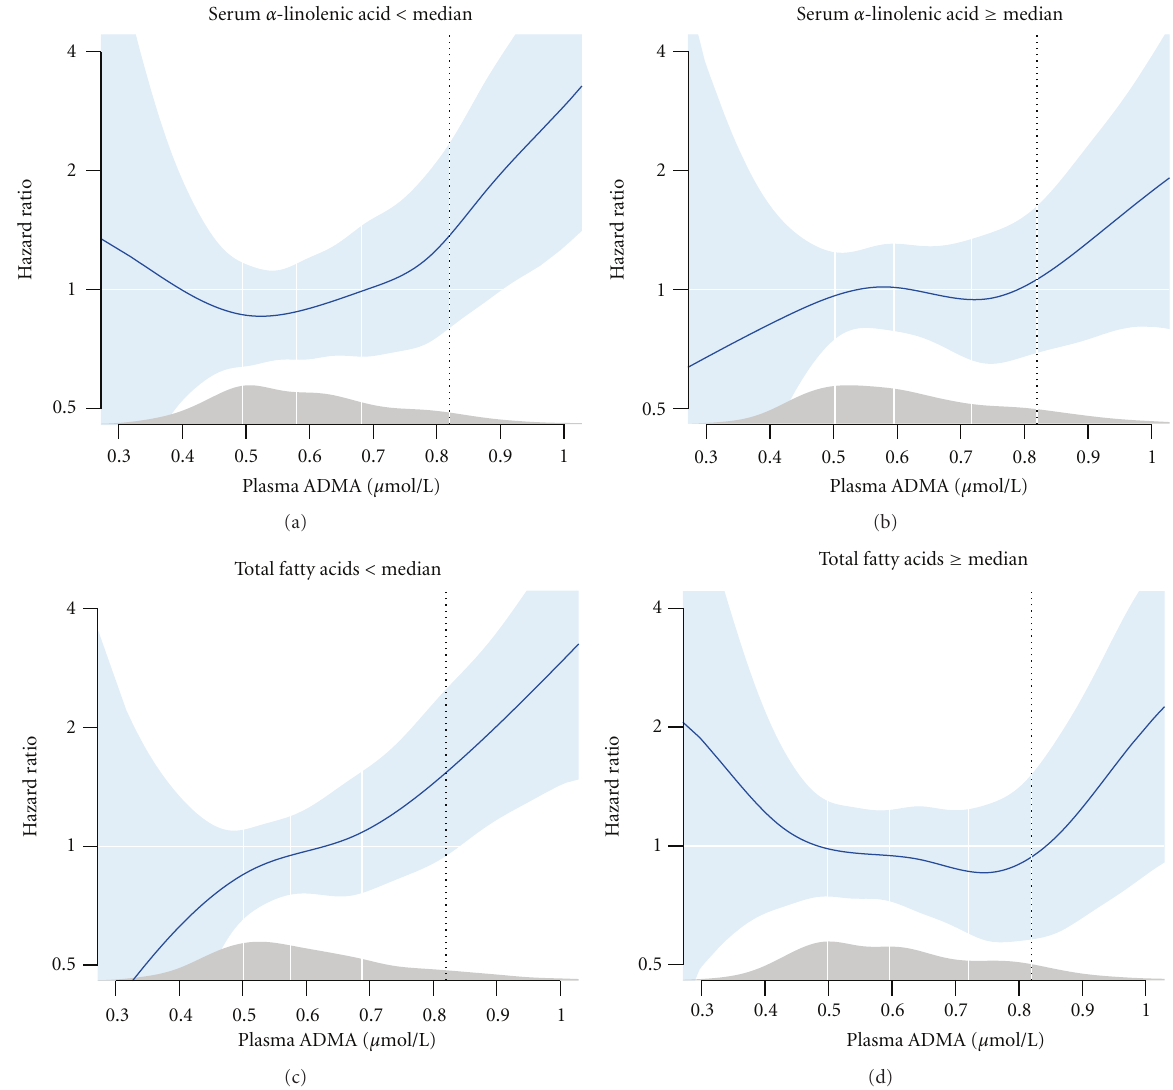
Figure 1: Association between plasma ADMA levels ( μ mol/L) and acute myocardial infarction in subsets of the study population with low/high serum levels of α -linolenic acid (upper panels) or total fatty acids (lower panels). Median serum levels of the specified fatty acid were used for the dichotomous separation of the study subjects. The nonlinear smoothing splines estimate of the hazard ratio were estimated with additive Cox proportional hazard regression models adjusted for age (continuous), sex, diabetes mellitus (yes/no), current smoking (yes/no), acute coronary syndrome (yes/no), extend of coronary artery disease (0–3), and left ventricular ejection fraction (continuous). The solid line represents the hazard ratio, and the shaded area represents the 95% CI. The density plot on top of the x -axis shows the distribution of plasma ADMA in the study population and the white vertical lines denote the first quartile, median, and third quartile, respectively; the dotted vertical line marks the population 90th